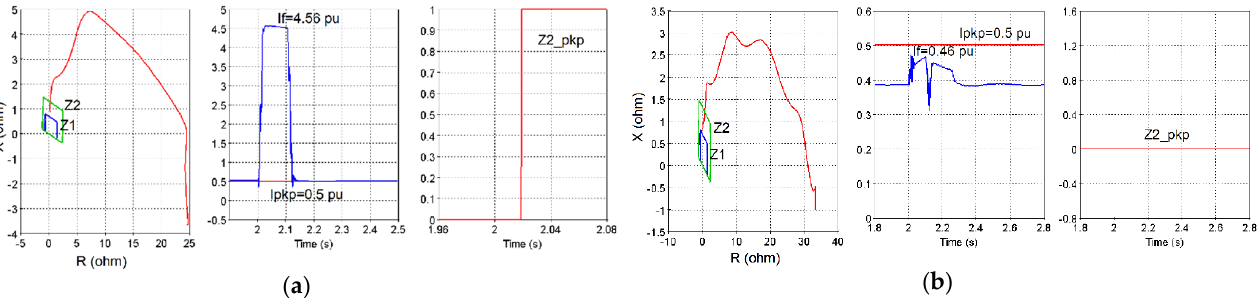
Figure 4. Comparison of response of a distance relay to a fault in zone 2 under ( a ) SG and ( b ) IBR.